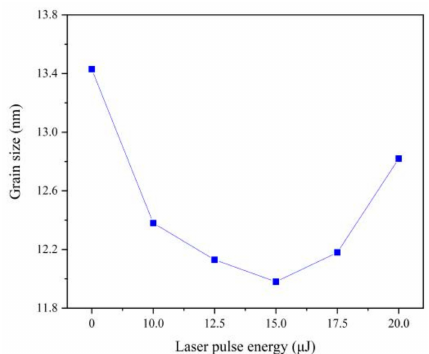
Figure 6. Grain size of coatings with varying laser energies.